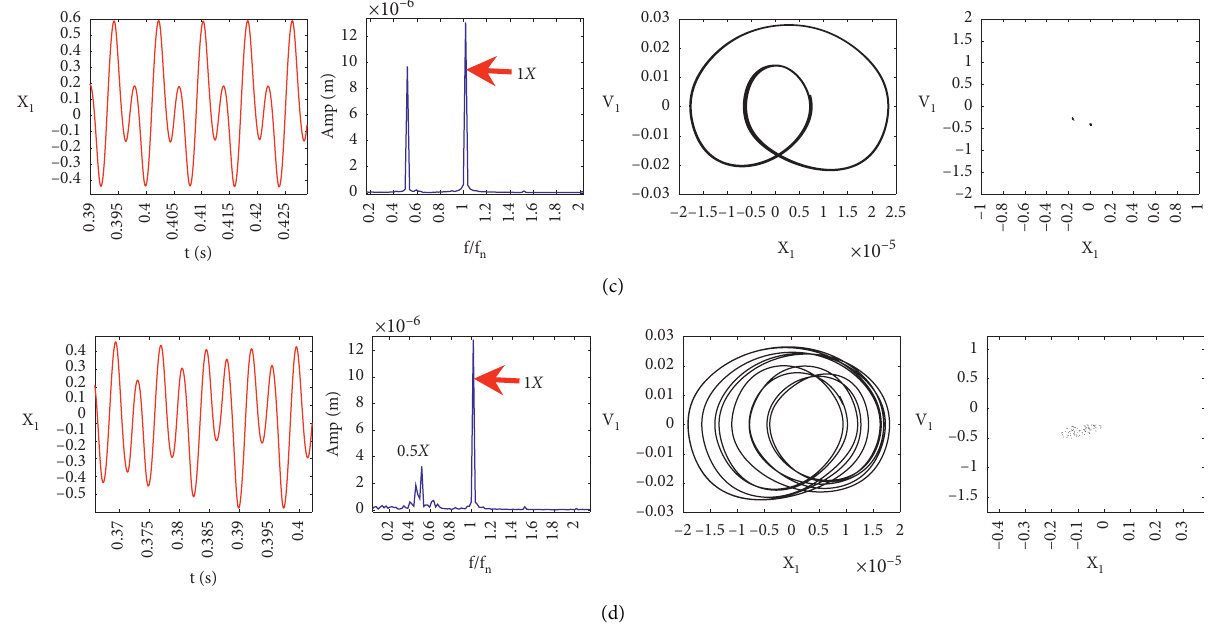
Figure 6: Dynamic behaviors at the typical rotating speed. (a) P-1 motion: (a1) time history, (a2) spectrum, chart of axis track, (a3) phase trajectory, and (a4) Poincar´e section when ω � 516 rad/s. (b) Multiple periodic motion: (b1) time history, (b2) spectrum, chart of axis track, (b3) phase trajectory, and (b4) Poincar´e section when ω � 1490rad/s. (c) P-2 motion: (c1) time history, (c2) spectrum, chart of axis track, (c3) phase trajectory, and (c4) Poincar´e section when ω � 1570rad/s. (d) Chaotic motion: (d1) time history, (d2) spectrum, chart of axis track, (d3) phase trajectory, and (d4) Poincar´e section when ω � 1675 rad/s.